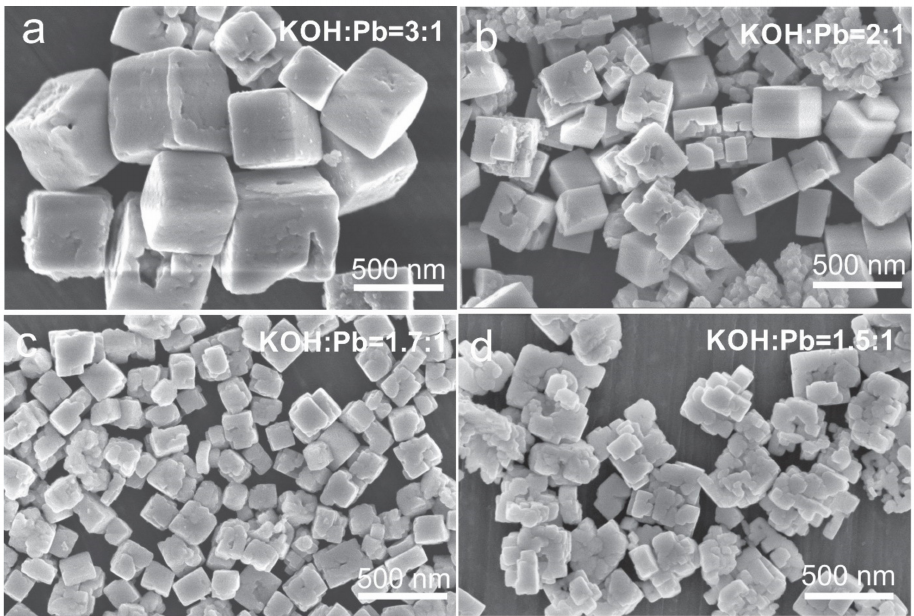
Figure 5. SEM micrographs (SE images) of the PZT06 reaction product obtained through two- step precipitation process and hydrothermal reaction at 235 ◦ C (12 h) and at ( a ) KOH:Pb = 3:1, ( b ) KOH:Pb = 2:1, ( c ) KOH:Pb = 1.7:1, and ( d ) KOH:Pb = 1.5:1. The optimal morphology (well- separated small PZT particles (80–280 nm (Figure 4)) are shown in ( c ) (KOH:Pb =